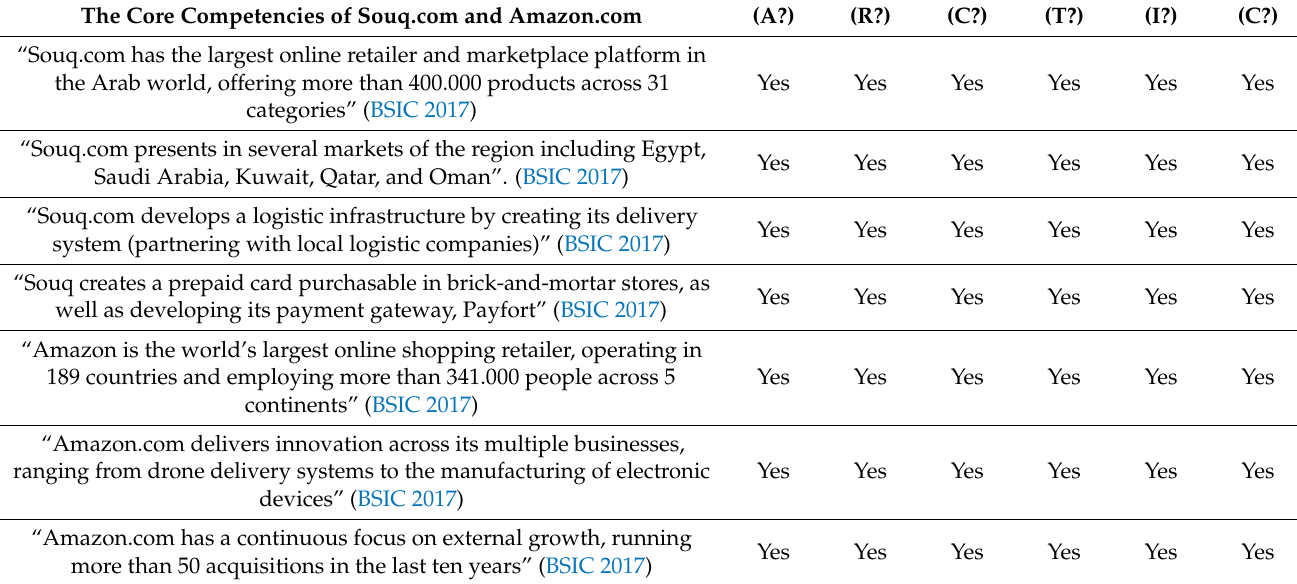
Table 2. The ARCTIC framework: Amazon.com’s acquisition of